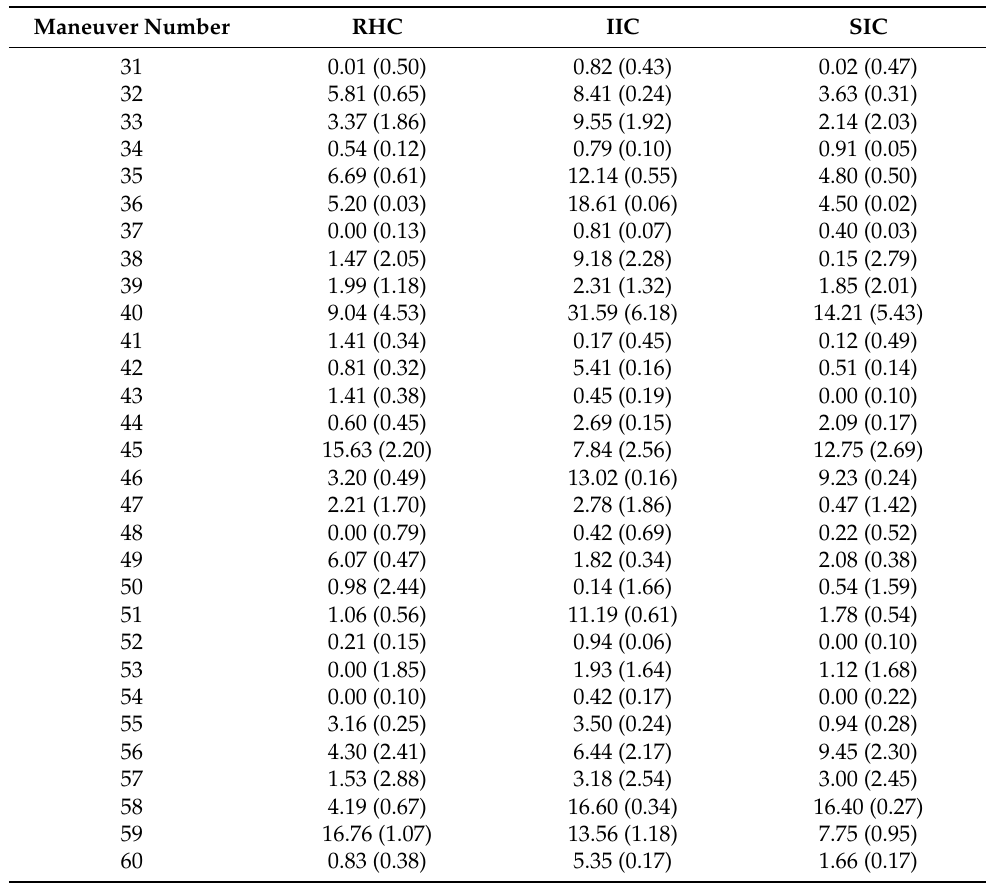
Table A2. Nadaraya–Watson estimates (bootstrapped standard error). From maneuver number 31 to